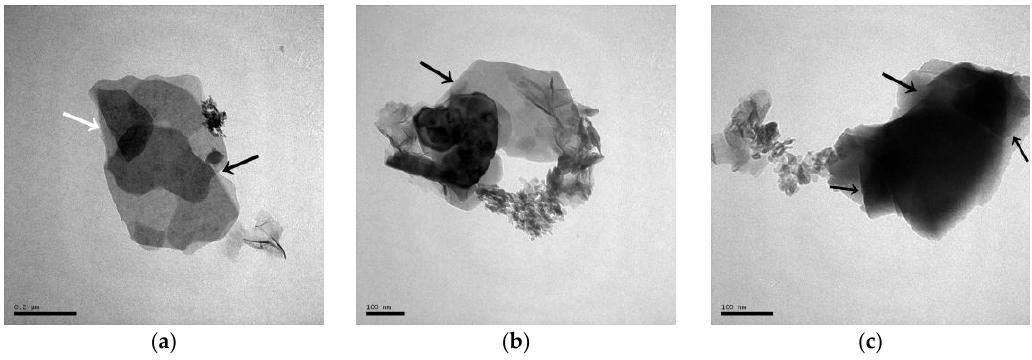
Figure 3. Transmission electron microscopy (TEM) images of C-A-S-H2.0_60_7d. ( a , b , c ) C-A-S-H2.0_60_7d